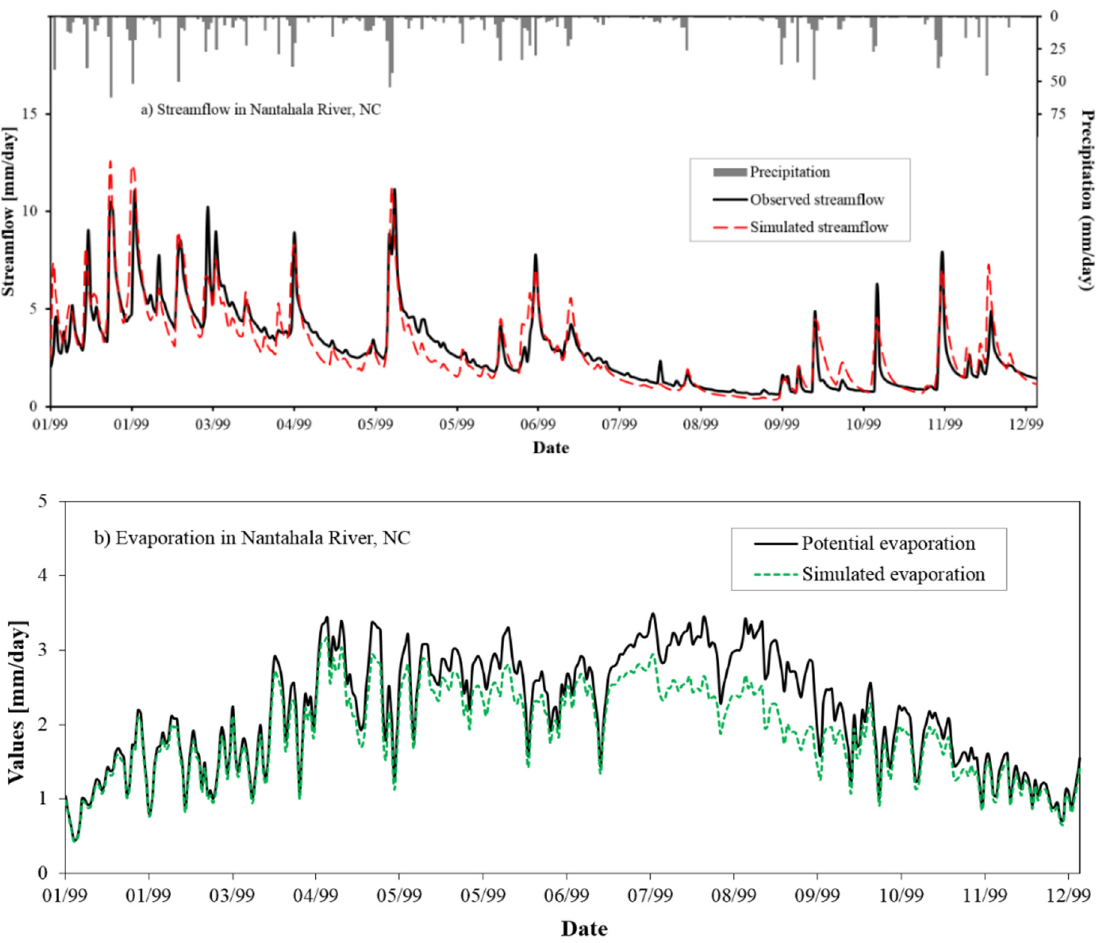
Figure 8. Simulation results for the Nantahala River, North Carolina (USGS gage #03504000), during the calendar year of 1999: ( a ) daily streamflow; ( b ) evaporation.